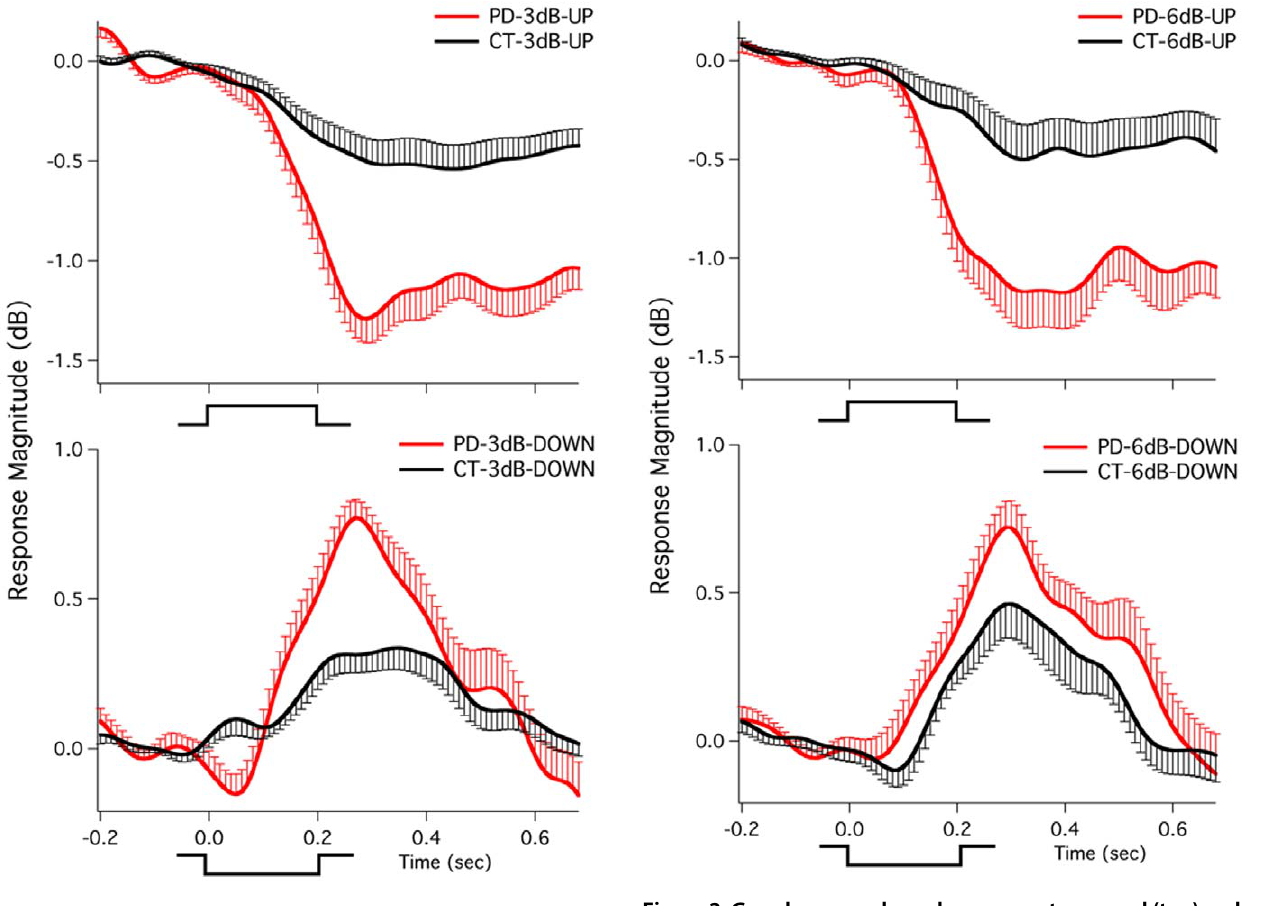
Figure 1. Grand-averaged vocal responses to upward (top) and downward (bottom) 3 dB perturbations across all PD and control subjects. The red and black lines denote the averaged responses produced by the PD and the control subjects, respectively. Vertical bars represent the standard errors of averaged traces. Stimulus timing and direction are illustrated by square trace at bottom of panels.